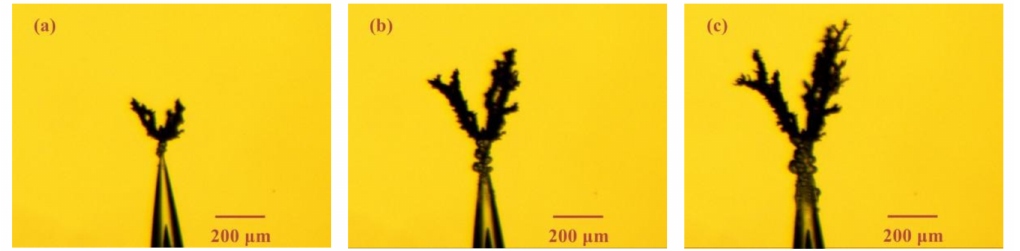
Figure 9. Electrical tree morphology in epoxy casting insulation sample with big air gap under 20 kHz / 8 kV bipolar square-wave voltage at time of ( a ) 5 min, ( b ) 20 min, ( c ) 40 min.